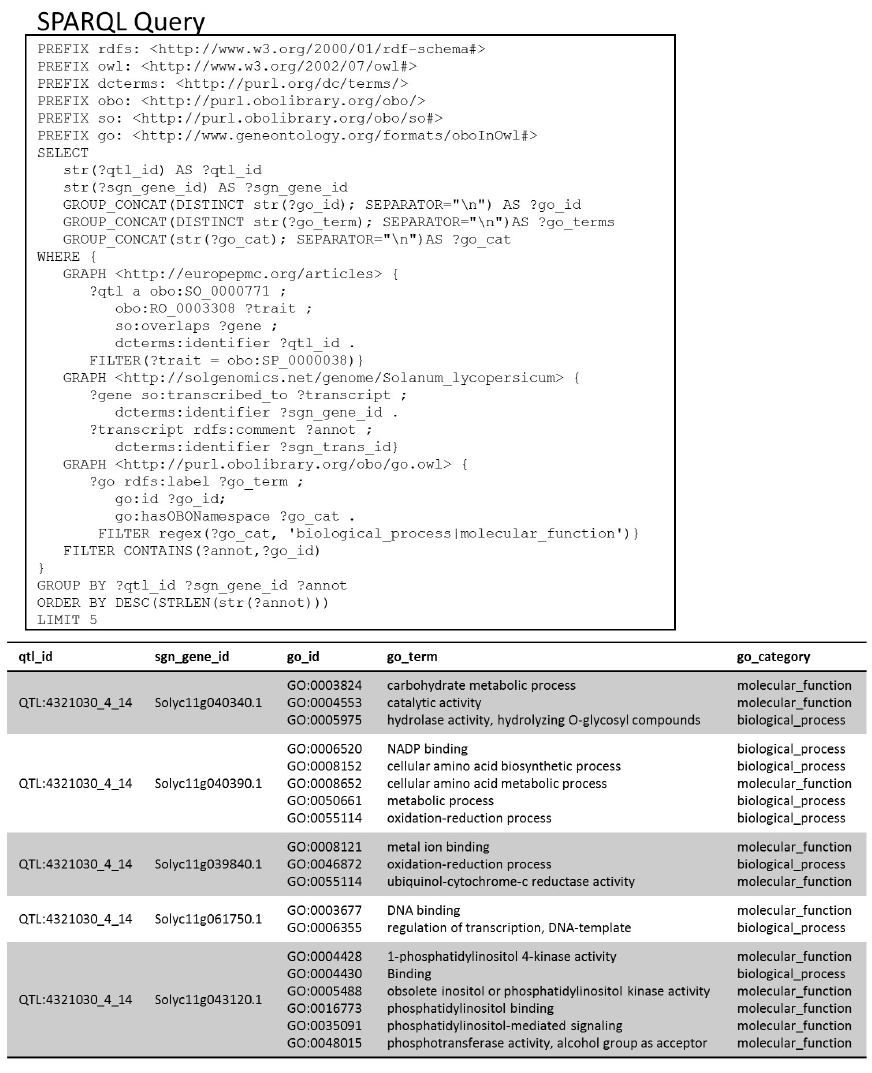
Figure 3. Input and output of the SPARQL query to list QTLs, associated gene IDs, and Gene Ontology (GO) annotations for the trait “fruit shape”